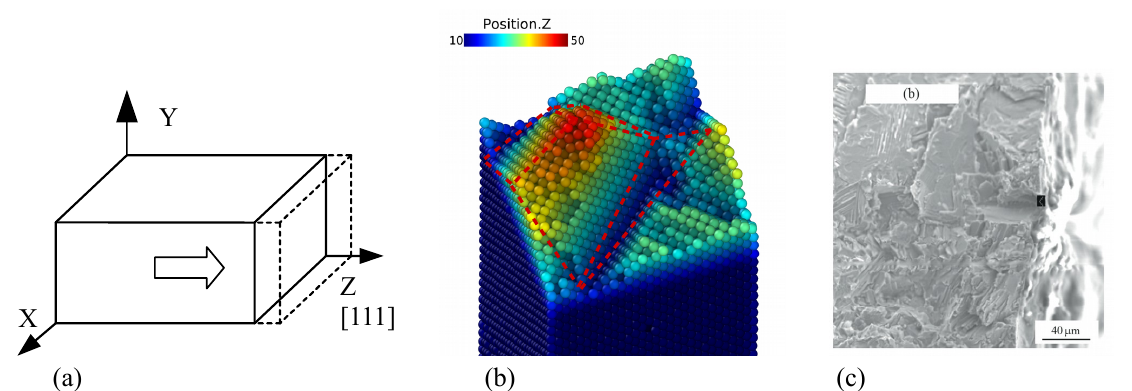
Figure 2. ( a ) Verifying model: TiAl single crystal bulk; ( b ) Cracked surface of atomic model; ( c ) Cracked surface from experiment [32].